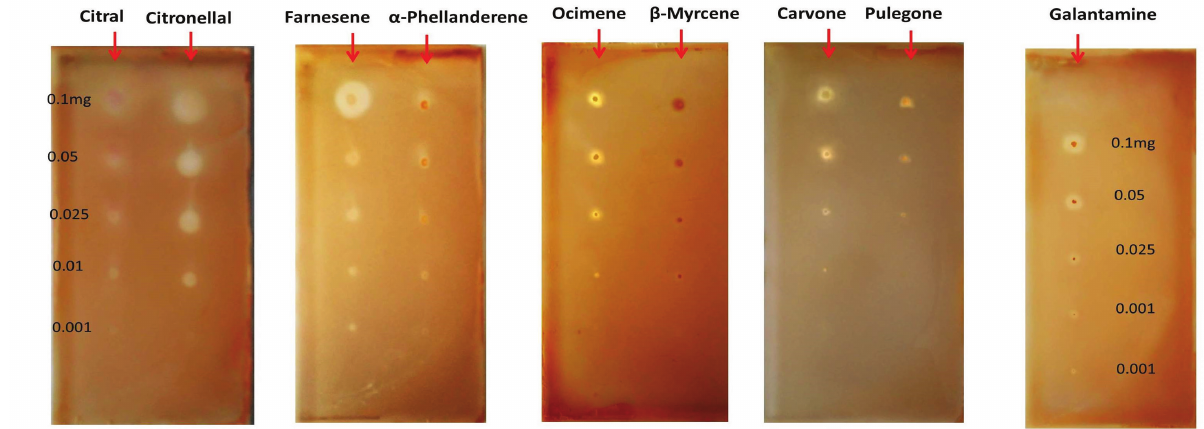
Figure 2: Marston assay results obtained for selected